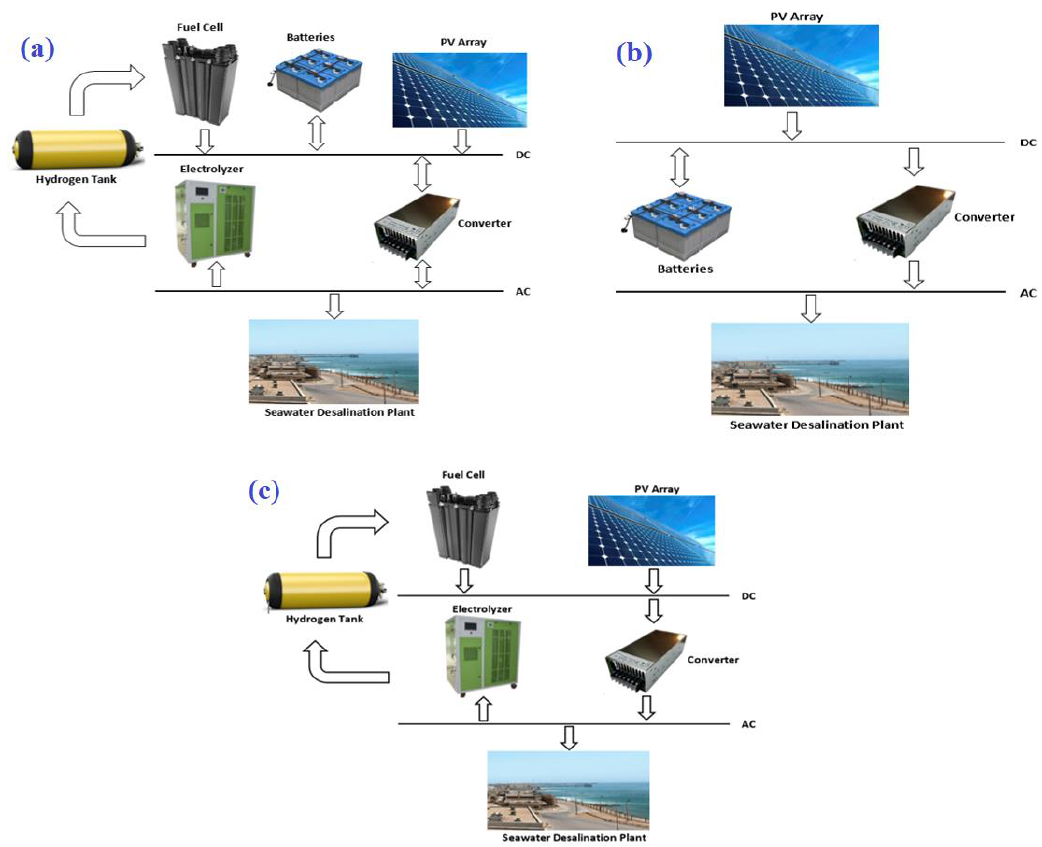
Figure 9. Schematic diagram of proposed hybrid renewable energy systems with different scenarios for supply AC load demand, an environmentally friendly seawater desalination plant; ( a ) first scenario: PV/FC/BS with a hydrogen storage system. ( b ) Second scenario: PV/BS system. ( c ) Third scenario: PV/FC with a hydrogen storage system. Table 2. Summary of proposed renewable energy system